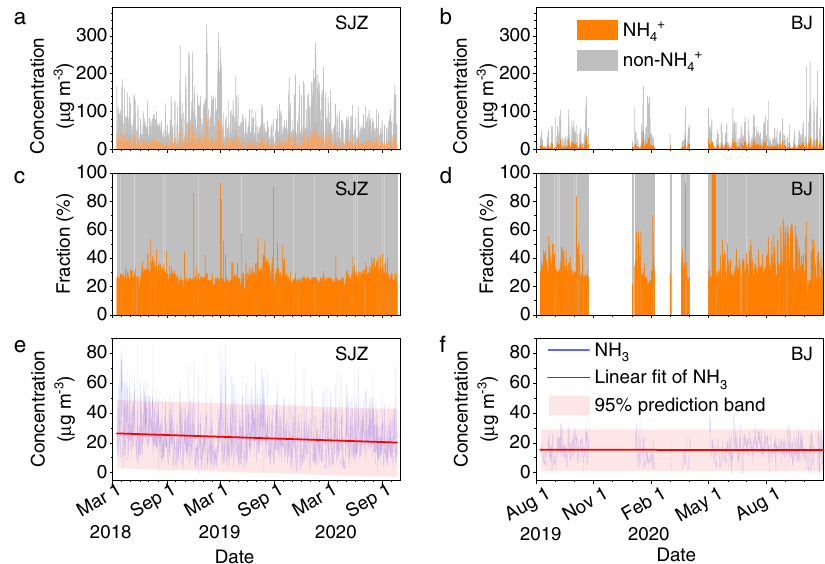
Fig.1|ConcentrationsofparticulateNH 4 + ,non-NH 4 + ionsandgas-phaseNH 3 . Thetimeseriesof( a , b )massconcentrationsofparticulateNH 4 + and non-NH 4 + inwater- soluble ions, ( c , d ) the relative fraction of particulate NH 4 + and non-NH 4 + ions, and ( e , f ) gas-phase NH 3 in Shijiazhuang (SJZ) and Beijing